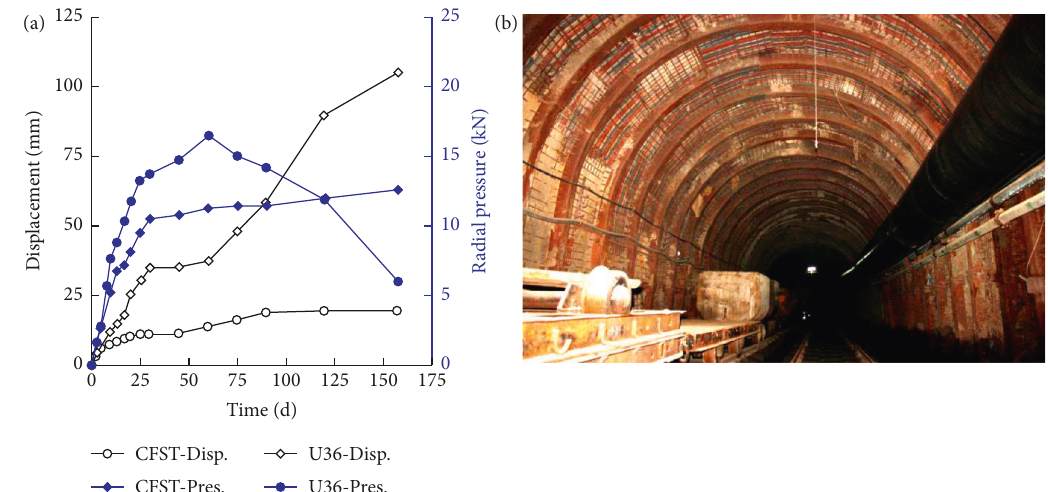
Figure 18: Effects of field test of CFSTarch-bolt composite scheme with arch locking bolts. (a) Monitoring curves. (b) Overall picture of the roadway 1.5 years